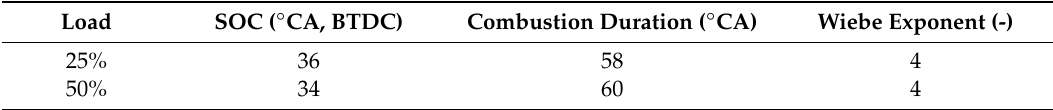
Table 4. Wiebe model parameters for the Engine